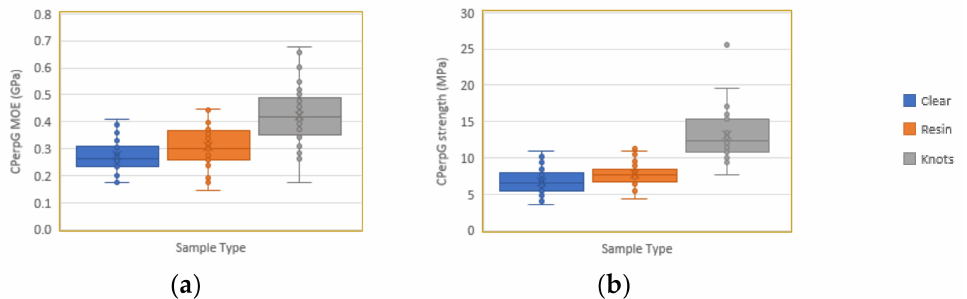
Figure 19. Box Plots of ( a ) CPerpG MOE and ( b ) CPerpG